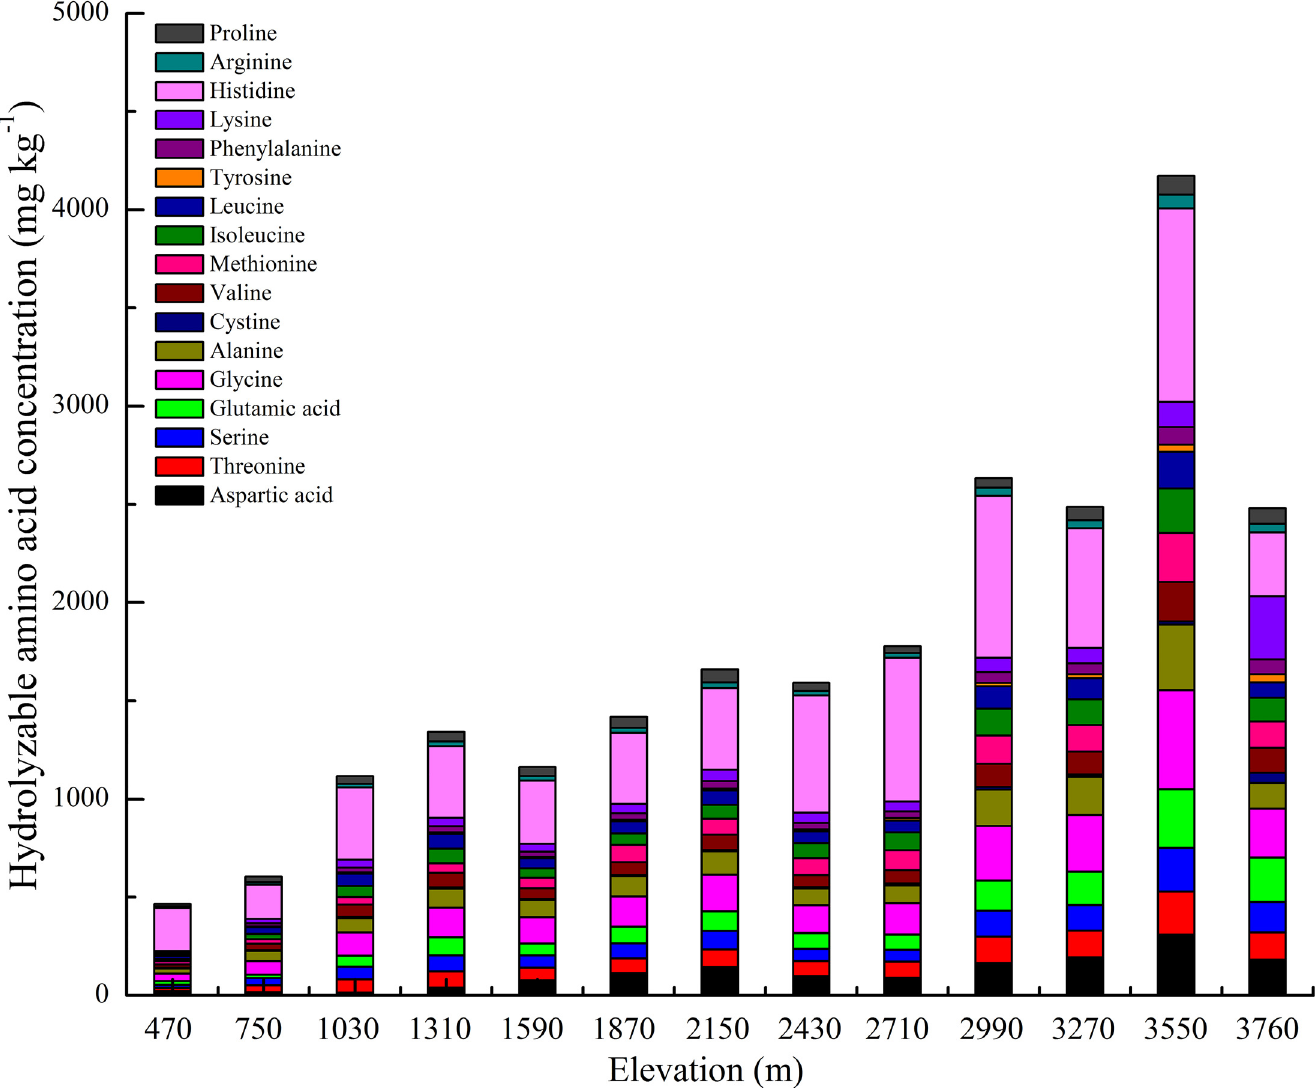
Fig 2. Concentrations of soil individual hydrolyzable amino acids in the thirteen sampled elevations. Error bars represent standard error (n = 3).